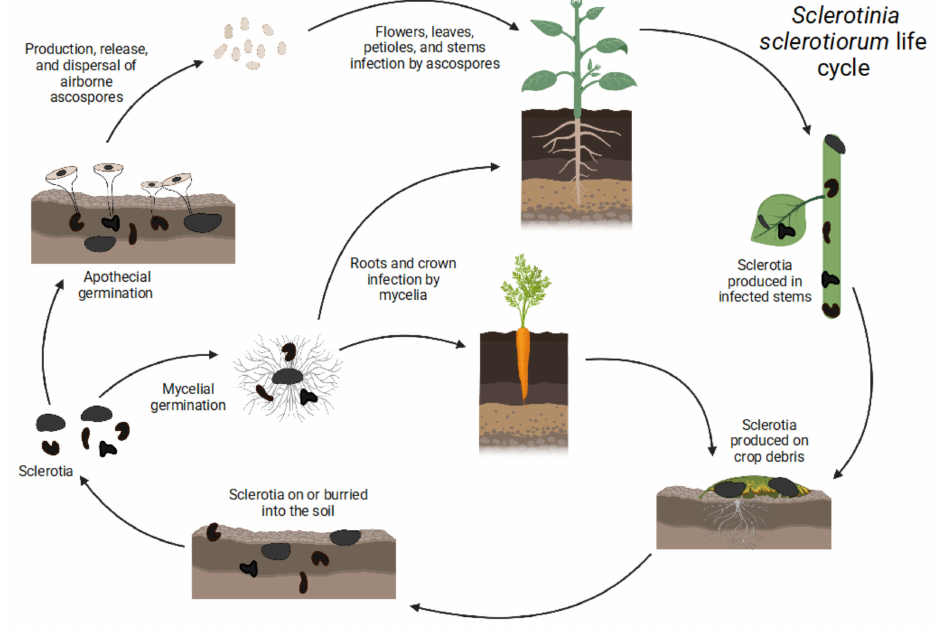
Figure 1. Sclerotinia sclerotiorum life cycle: Carpogenic and myceliogenic germination of